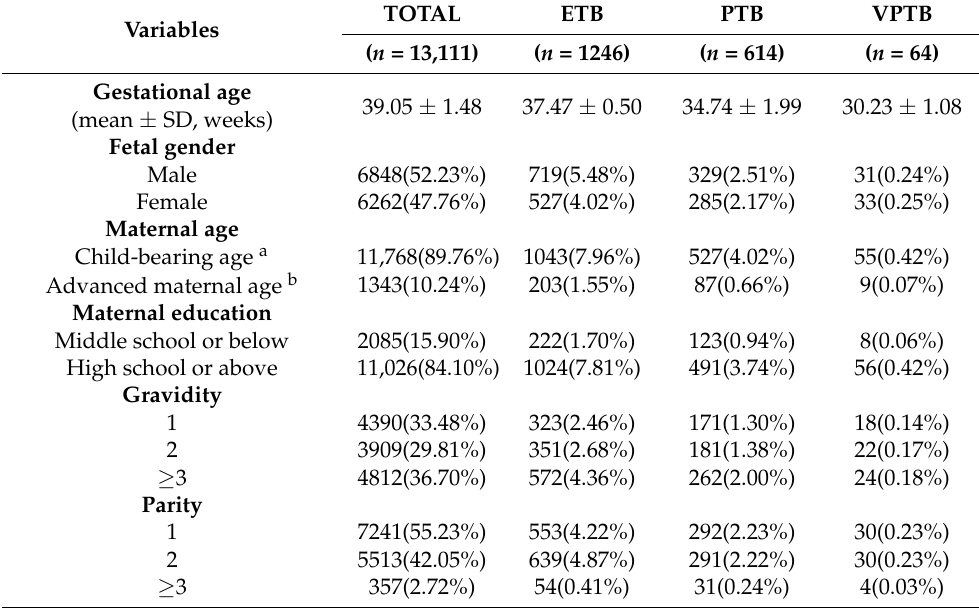
Table 1. The descriptive summary of the general characteristics of all the